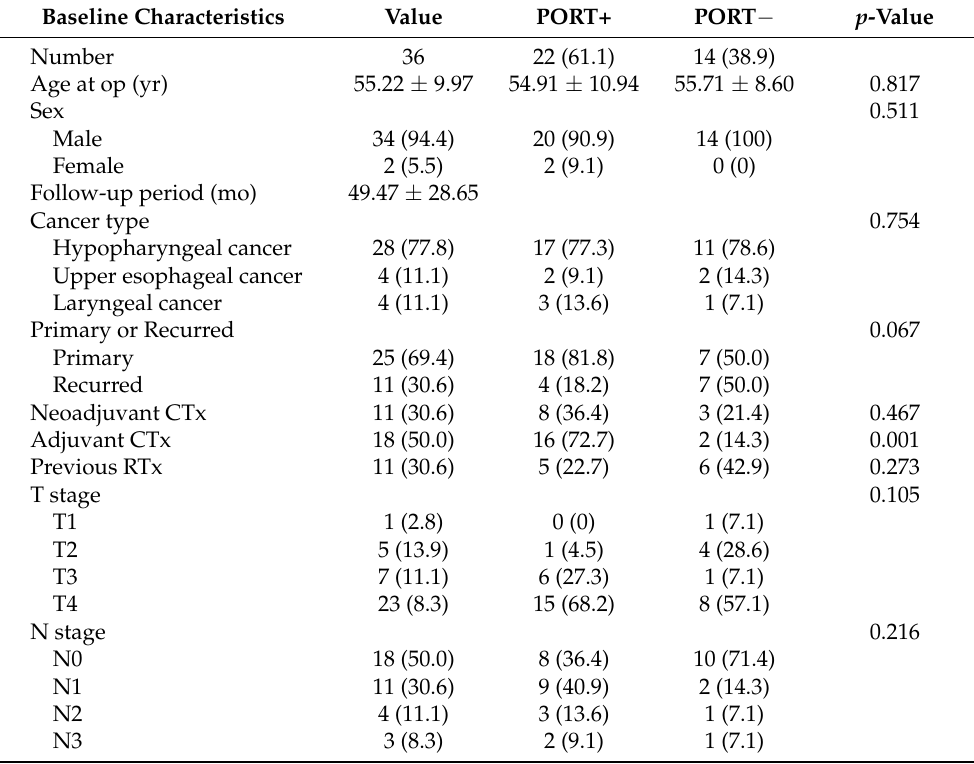
Table 2. Baseline characteristics of the study